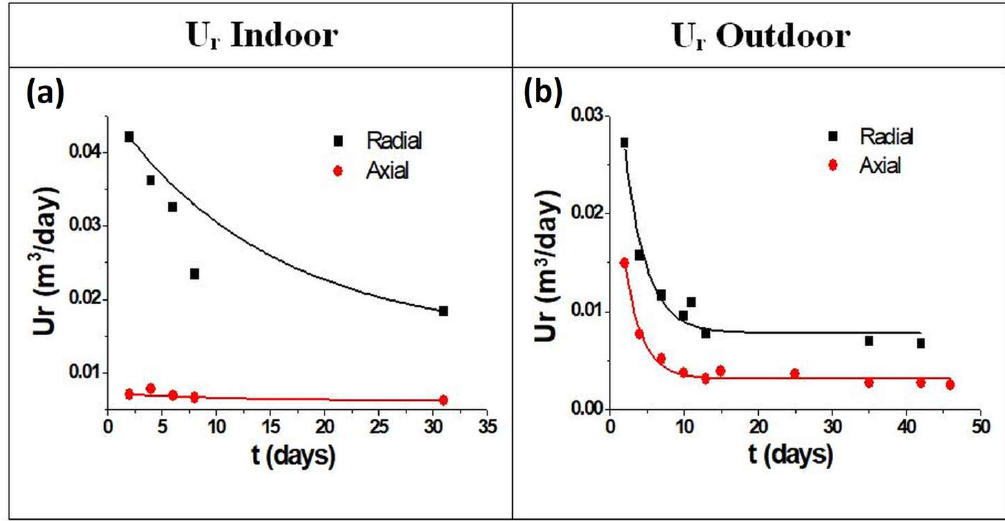
Figure 6. U r of the sample shelters following the indoor ( a ) and outdoor ( b ) exposures.